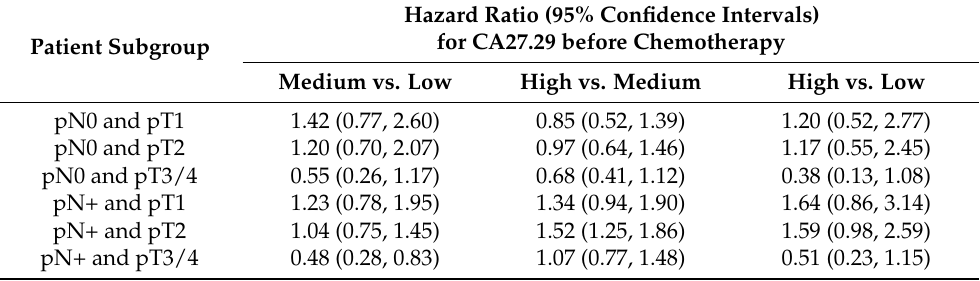
Table 2. Cox Regression Analysis of Disease-Free Survival, * Showing Subgroup-Specific † and Adjusted ‡ Hazard Ratios for CA27.29 before Chemotherapy, with 95% Confidence Intervals.